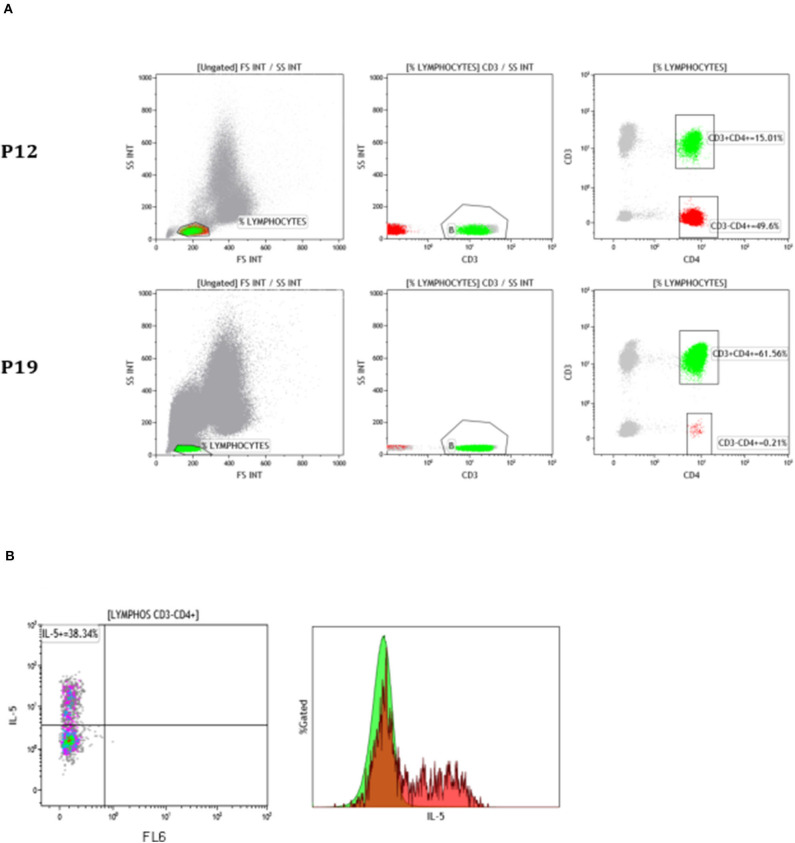
T cell phenotyping by flow cytometry in 2 representative patients with a CD3−CD4+ T cell subset. (A) T cell phenotyping by flow cytometry showing a large (P12, top) and a small (P19, bottom) CD3-CD4+ T cell subset. The plots show the gating strategy from left to right: gate on lymphocytes on the basis of forward- and side-scatter, after selecting CD45hi cells (not shown) CD3 expression is plotted against side-scatter and CD3+ cells (green) are differentiated from CD3- cells (red), the proportions of CD3+CD4+ and CD3−CD4+ T cells among CD45hi cells are shown on the right. (B) Intracytoplasmic IL-5 expression was assessed in CD4 T cells from patient P19. The histogram overlay shows IL-5 expression in CD3+CD4+ T cells (green) and in CD3−CD4+ cells (red).